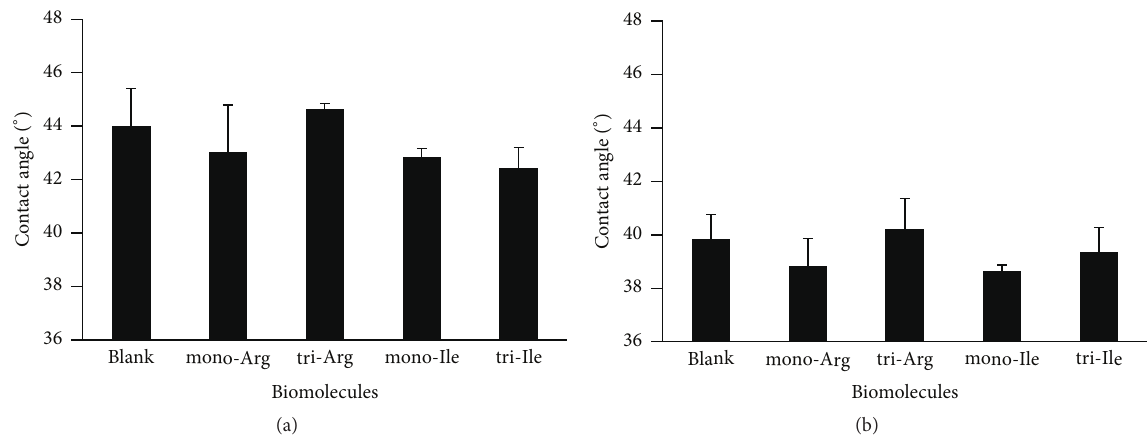
Figure 3: Contact angles (CAs) on the cell assay platform in this study measured at (a) 37 ∘ C and (b) 20 ∘ C.